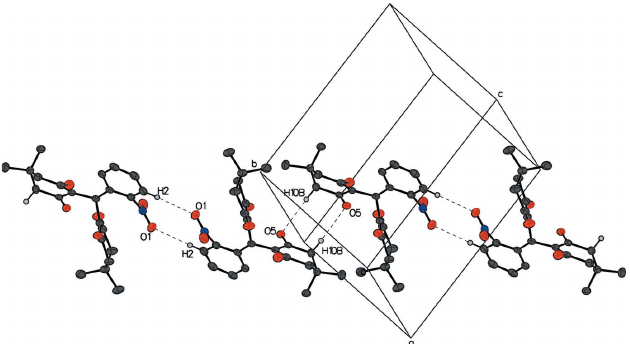
Figure 6 The packing of compound I showing a chain of alternating enantiomers. For clarity, H atoms not participating in hydrogen bonds are omitted, and participating atoms are labeled once.